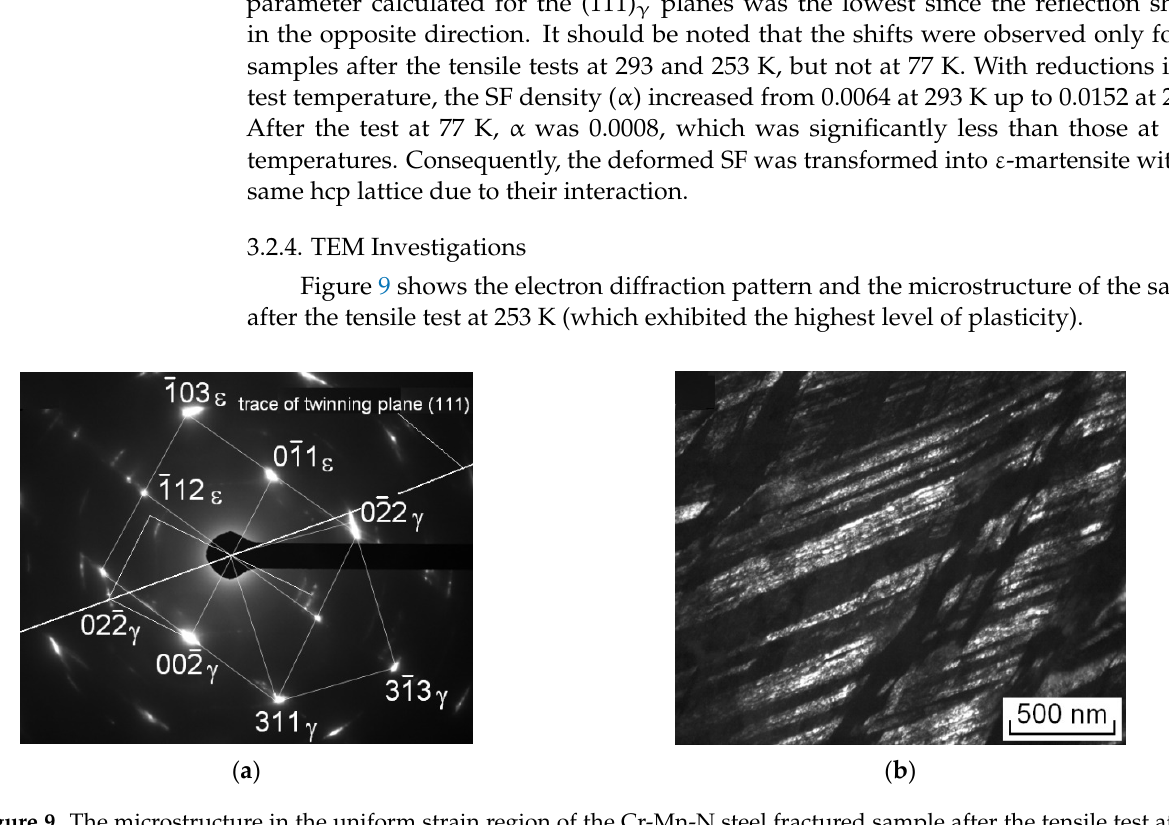
Figure 9. The microstructure in the uniform strain region of the Cr-Mn-N steel fractured sample after the tensile test at 253 K: ( a ) the reflex grid electron diffraction pattern of the γ -phase (z = [100] γ and z = [ 2 33] γ ) as well as ε - martensite z = [311] ε ; ( b ) the dark-field image of ε - martensite in the ( 121 ) ε reflex.